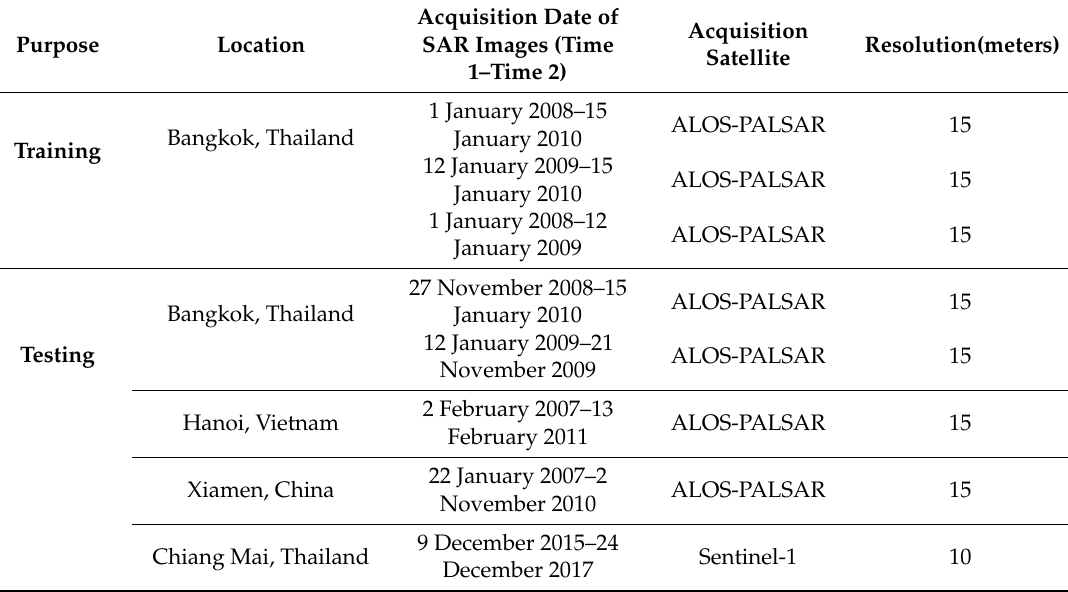
Table 2. Acquisition information of dataset. SAR—synthetic-aperture